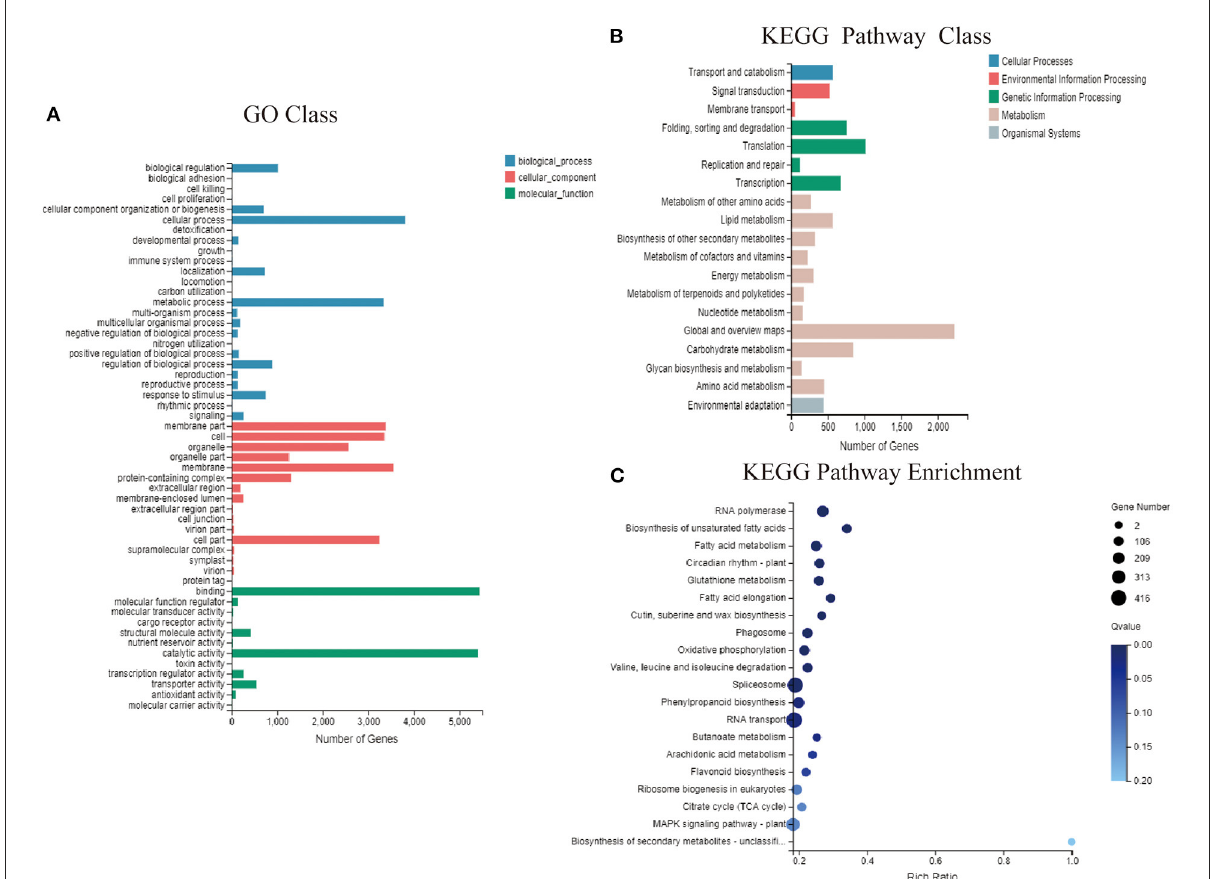
FIGURE5 GO and KEGG functional enrichment analysis. (A) Functional distribution of GO annotations. (B) KEGG function distribution statistics. (C) KEGG function-enriched bubble chart.